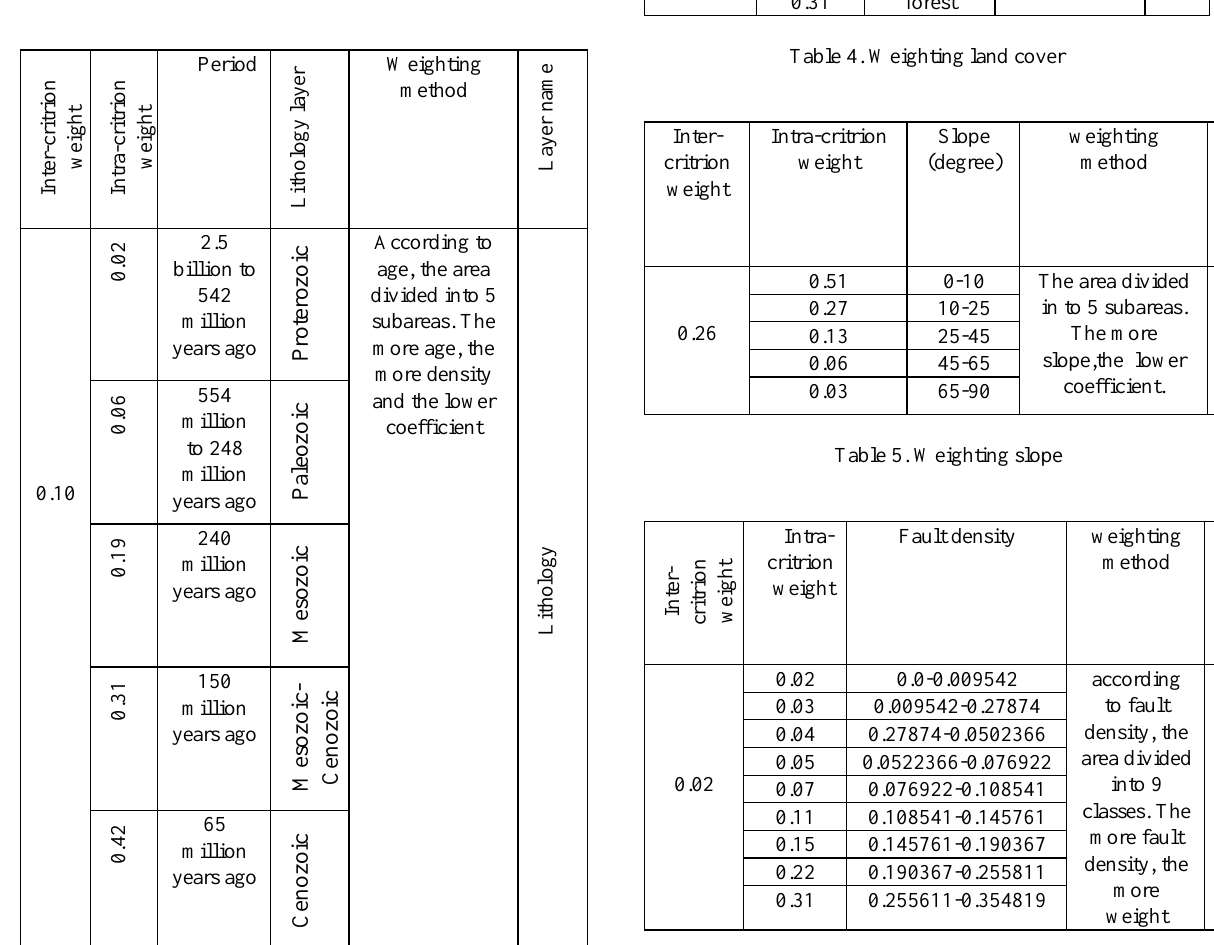
Table 6. Weighting faults